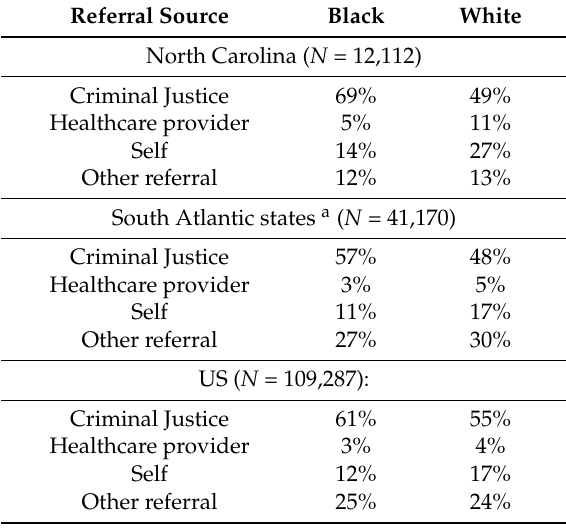
Table 1. Admissions to outpatient treatment with DSM diagnosis of either cannabis dependence or cannabis abuse, by race (blacks and whites) and referral source, 2011. Referral Source Black White North Carolina ( N = 12,112) Criminal Justice 69% 49% Healthcare provider 5% 11% Self 14% 27% Other referral 12% 13% South Atlantic states a ( N = 41,170) Criminal Justice 57% 48% Healthcare provider 3% 5% Self 11% 17% Other referral 27% 30% US ( N = 109,287): Criminal Justice 61% 55% Healthcare provider 3% 4% Self 12%